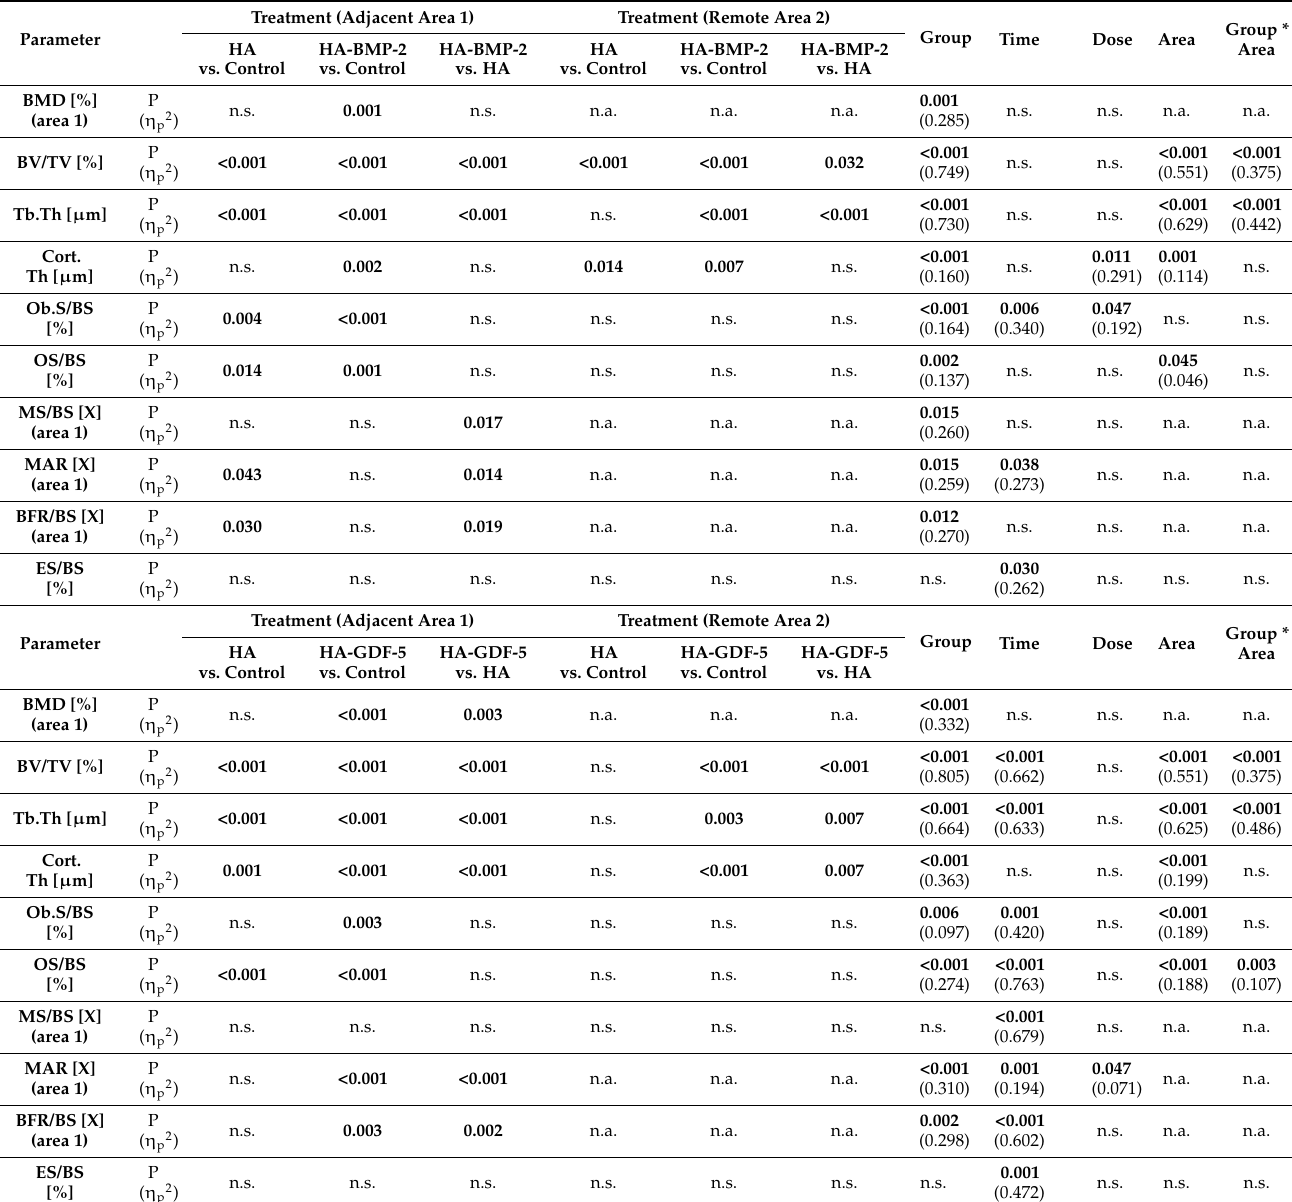
Table 2. Results of the linear mixed effects model for treatment (group), time point (time), BMP dose (dose), and area-related effects of BMP-2 or